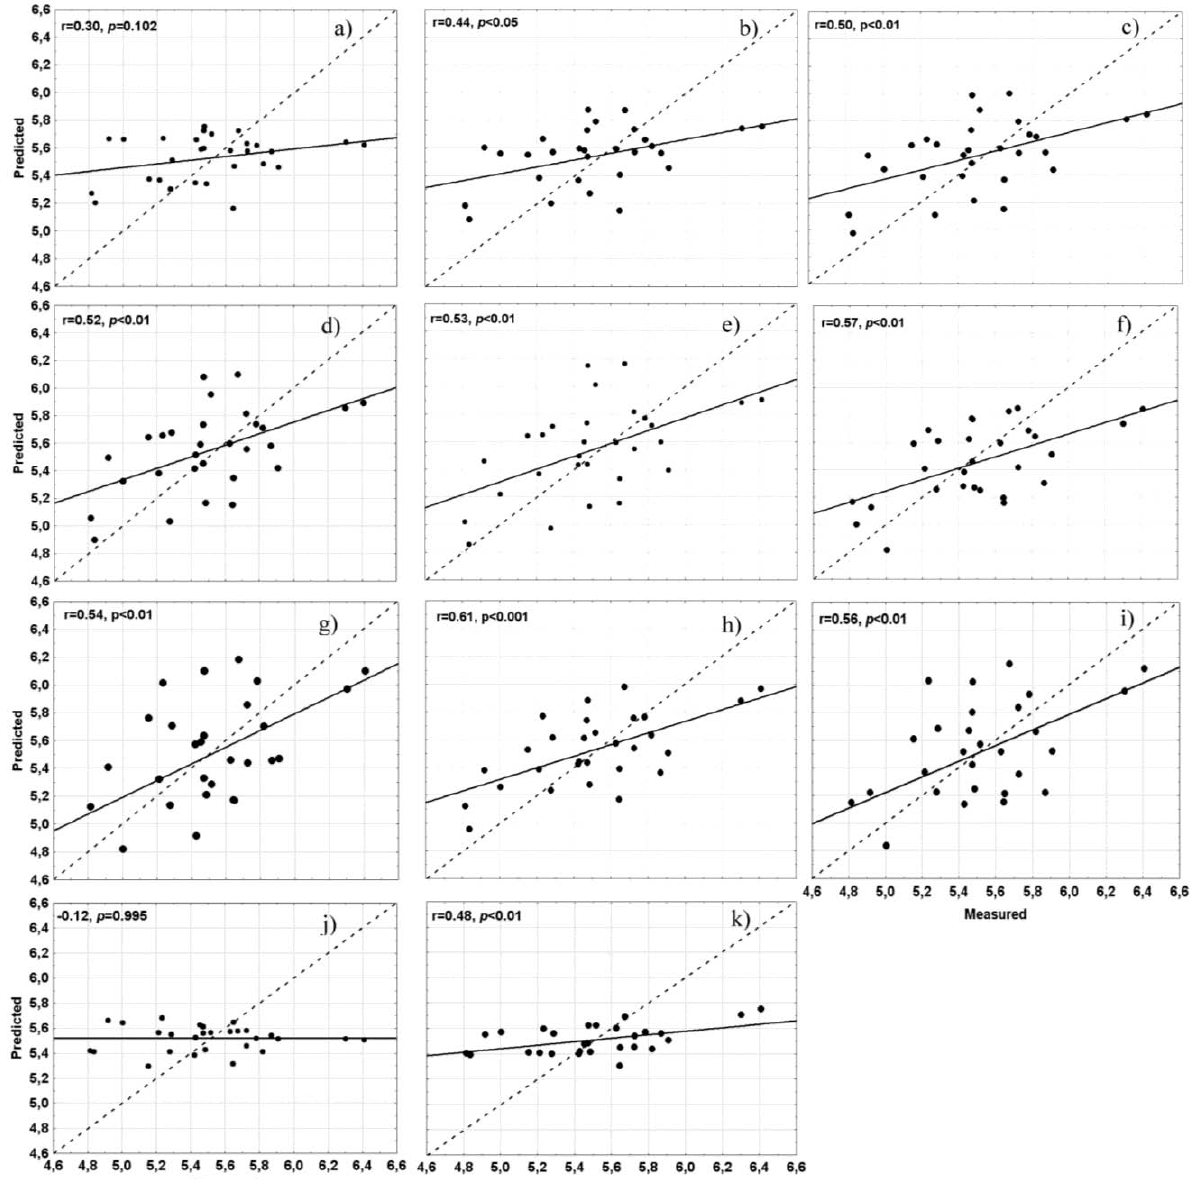
Fig. 4. Scaterplots of the observed against estimated values in the studied interpolation methods. a) IDW1, b) IDW2, c) IDW3, d) IDW4, e) IDW5, f) LP1, g) LP2, h) SPT, i) TPS, j) OK, k) COK. Bold line (best linear fit), and dotted line